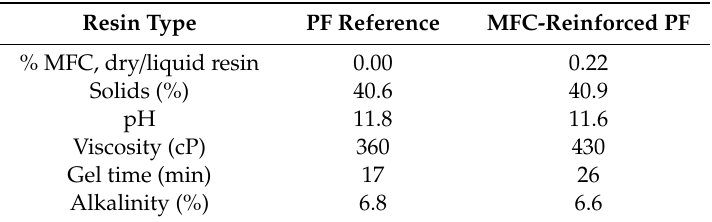
Table 10. Phenol-Formaldehyde (PF) resin analysis results,